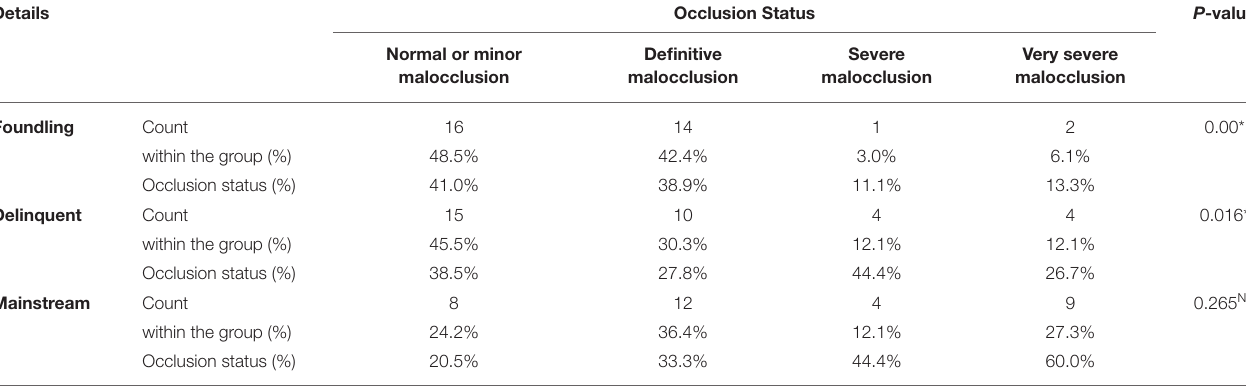
TABLE 5 | The occlusion status in foundling, delinquent and mainstream children groups according to the Dental Aesthetic Index. Details